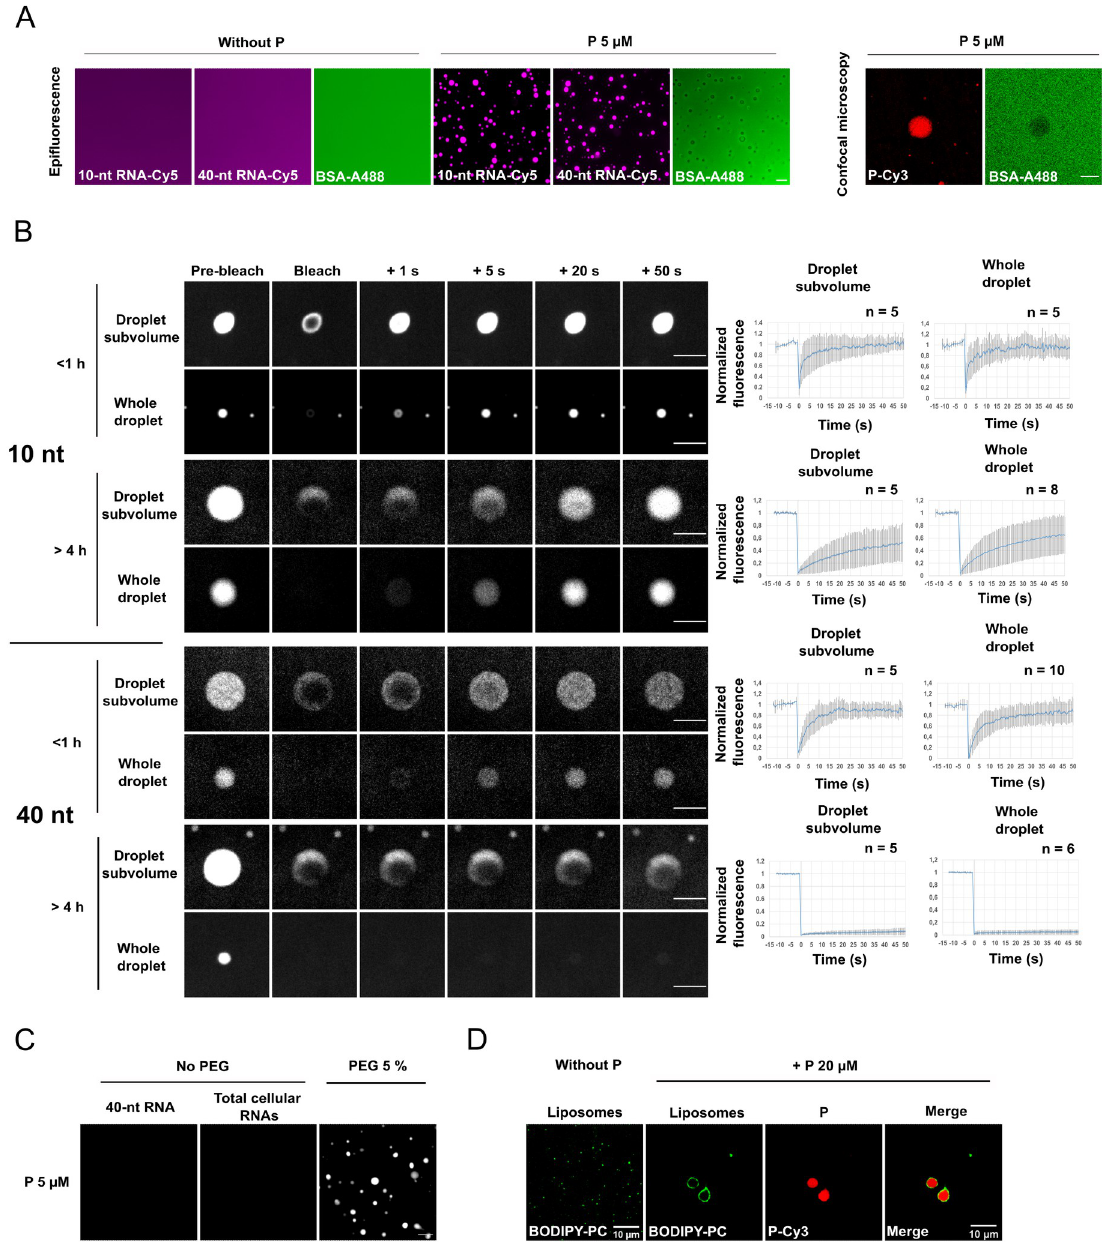
Fig 6. Biologically relevant properties of RABV P droplets. A) Segregation of RNA-Cy5 (10- or 40-A nucleotides) at the concentration of 100 nM into non-fluorescent P droplets (P at 5 μ M in presence of 5% PEG 8000 in 125 mM NaCl, 20 mM Tris-HCl pH 7.5) and exclusion of BSA-FITC at the concentration of 250 μ g/ml (3.8 μ M) from P droplets. Fluorescent RNA and BSA were added when LLPS was induced. Analysis was performed by fluorescence microscopy. Exclusion of BSA-FITC from P droplets was validated by confocal microscopy (right panel). Scale bars: 10 μ m. B) Droplets formed by non-fluorescent P at the concentration of 20 μ M in the presence of 5% PEG 8000 and 100 nM Cy5-RNAs in 125 mM NaCl, 20 mM Tris-HCl pH 7.5 were photobleached at different time-points post-mixing (less than 1 h or more than 4 h). Whole droplets as well as droplets subvolumes were photobleached. Images were acquired on a spinning disk confocal microscope. Scale bars: 5 μ m. For the plots on the right, FRAP data were corrected for background, normalized to the minimum and maximum intensity. The mean is shown with error bars representing the SD. C) P at 5 μ M (25 nM of fluorescent P protein) in 50 mM NaCl, 20 mM Tris-HCl pH 7.5 was incubated with either 5% PEG 8000, or 80 ng/ μ L (6 μ M) of synthetic 40-A nucleotides RNA, or 80 ng/ μ L of total RNAs extracted from BSR-T7/5 cells. Presence of droplets was assessed by fluorescence microscopy. Scale bar: 10 μ m. D) Fluorescent liposomes (PE/PC/PS = 2/2/1 w/w, 100 μ g/ml i . e . ~130 μ M of lipids containing 0.25% of BODIPY 500/510 C12-HPC) were incubated or not with P at 20 μ M concentration (50 nM of fluorescent P protein) in 5% PEG 8000, 125 mM NaCl, 20 mM Tris-HCl pH 7.5 before analysis by confocal microscopy. Scale bars: 10 μ m.